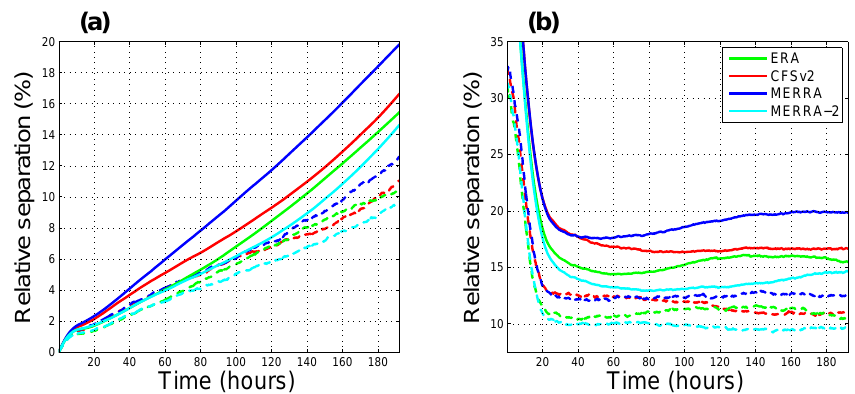
Figure 7. Relative trajectory separations as a function of time. (a) is similar to Fig. 5a except here, prior to deriving the statistics, the separation of each reanalysis trajectory is normalized by the total distance travelled by the balloon during those 8 days. (b) is similar, except here the separations are divided by the the current distance travelled by the balloon, not the